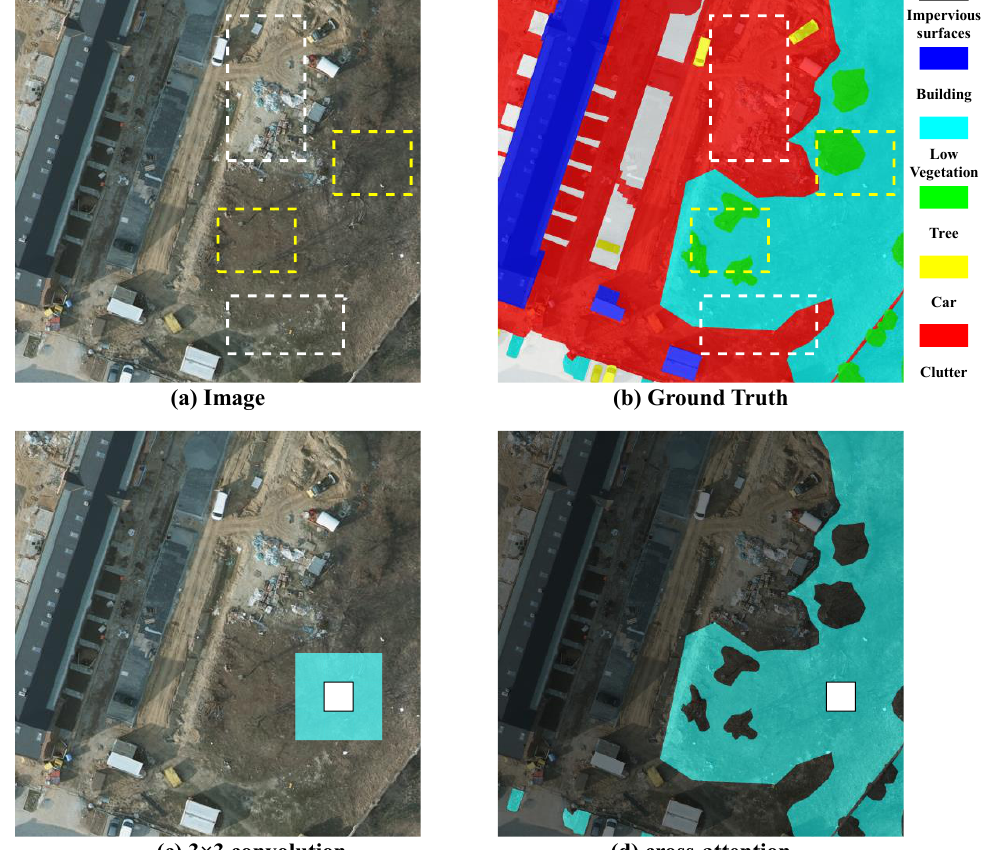
Figure 1. Illustration of a remote sensing image sample and cross-attention. ( a ) Image from the Potsdam dataset, ( b ) ground truth of the image. The sample pair presents the complex background: there are many objects with different features in the background category, and interclass similarity: overlap of the same features between different classes. The second row represents the comparison in the context extraction method between 3 × 3 convolution and cross-attention: ( c ) nine pixels near the sample point; ( d ) a set of pixels from the same class.